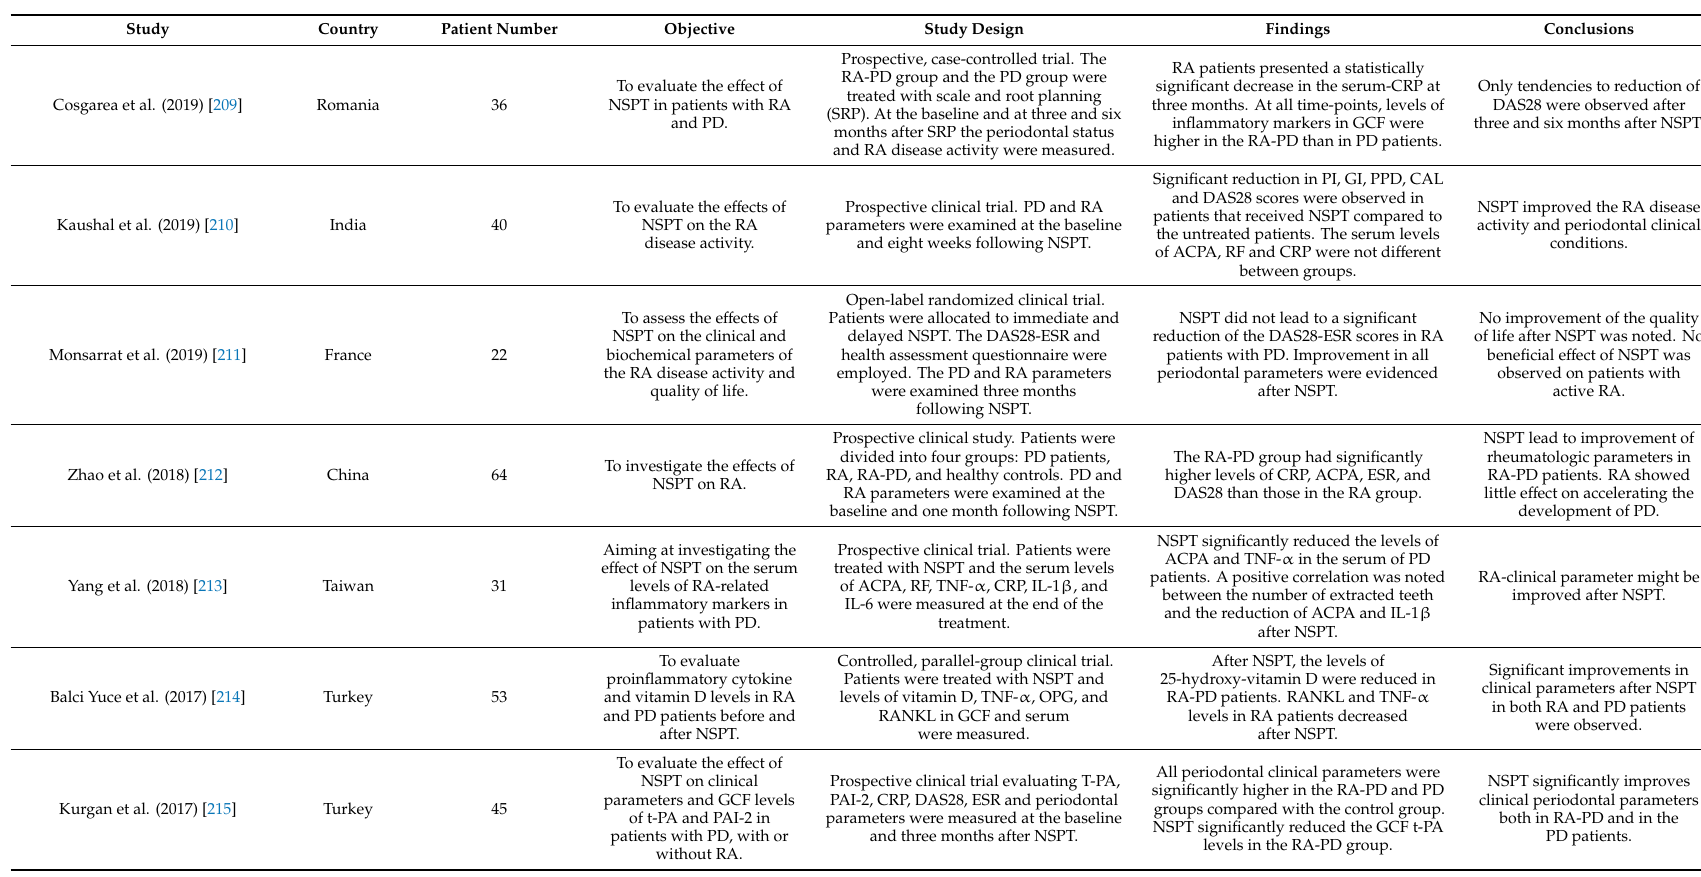
Table 2. Evidence table summarizing the main outcomes of clinical trials evaluating the e ff ects of nonsurgical periodontal treatment (NSPT) in patients with active